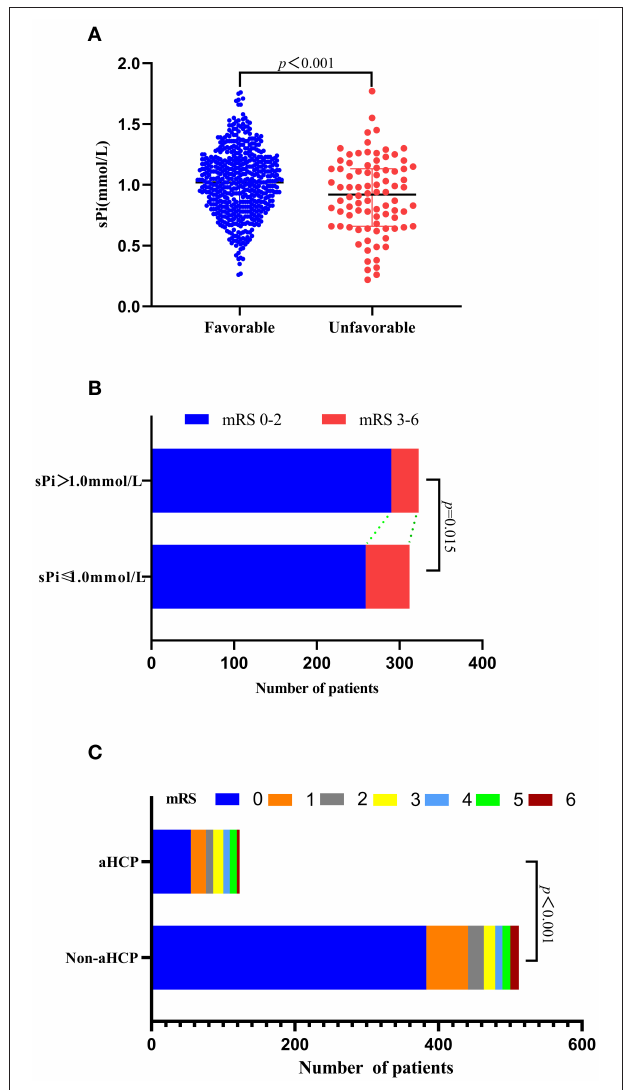
FIGURE 4 | Association of sPi level with unfavorable 90 days functional outcome. (A) sPi levels in aSAH patients with favorable (mRS 0–2, n = 549) and unfavorable (mRS 3–6, n = 86) outcome. (B) Function outcome at 90 days for patients with lower sPi (sPi ≤ 1.0 mmol/L, n = 312) and higher sPi (sPi>1.0 mmol/L, n = 323) than medium level (1.0 mmol/L). Data are reported as scatter-dot plots and median with IQR in (A) . (C) Distribution of functional outcomes at 90 days between patients with aHCP and non-aHCP. Mann-Whitney tests were performed to compare differences in sPi levels between patients with favorable (mRS 0–2) and unfavorable outcomes (mRS 3–6). aSAH: aneurysmal subarachnoid hemorrhage; IQR, interquartile range; mRS: modified Rankin Scale; sPi, serum phosphate